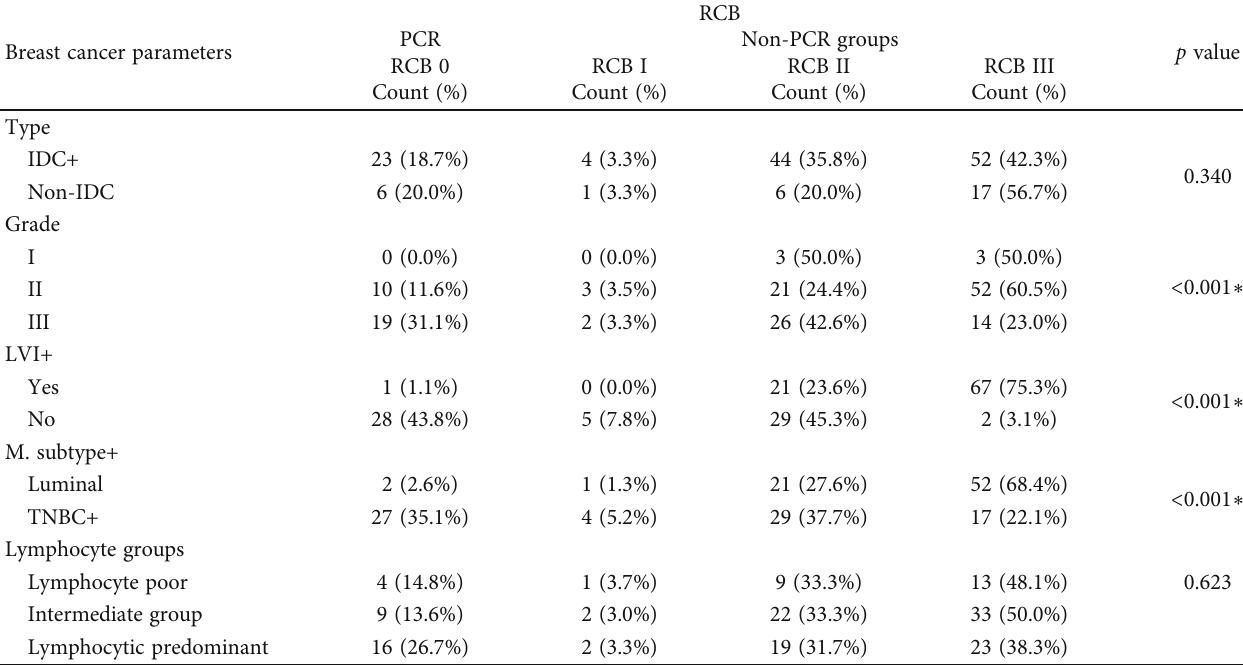
Table 2: Association (count (%)) between various parameters of 153 breast cancer cases and RCB classes (chi-square test). Breast cancer parameters